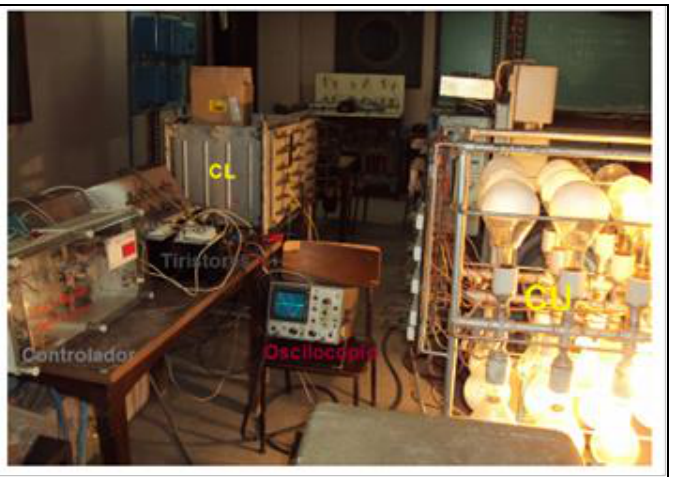
Figura 7: Prototipo de pruebas experimentales para control local de la mini-hidroeléctrica Fuente: [27].